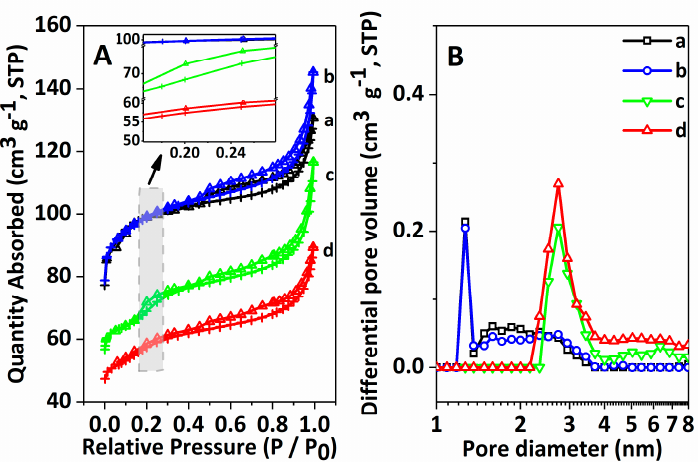
Figure 3. ( A ) N 2 adsorption/desorption isotherms and ( B ) the corresponding pore-size distribution as derived from N2 sorption (DFT on the adsorption branch) of ( a ) H-ZSM-5, ( b ) Fe/ZSM-5, ( c ) H-ZSM-ST and ( d ) Fe/ZSM-5-ST.